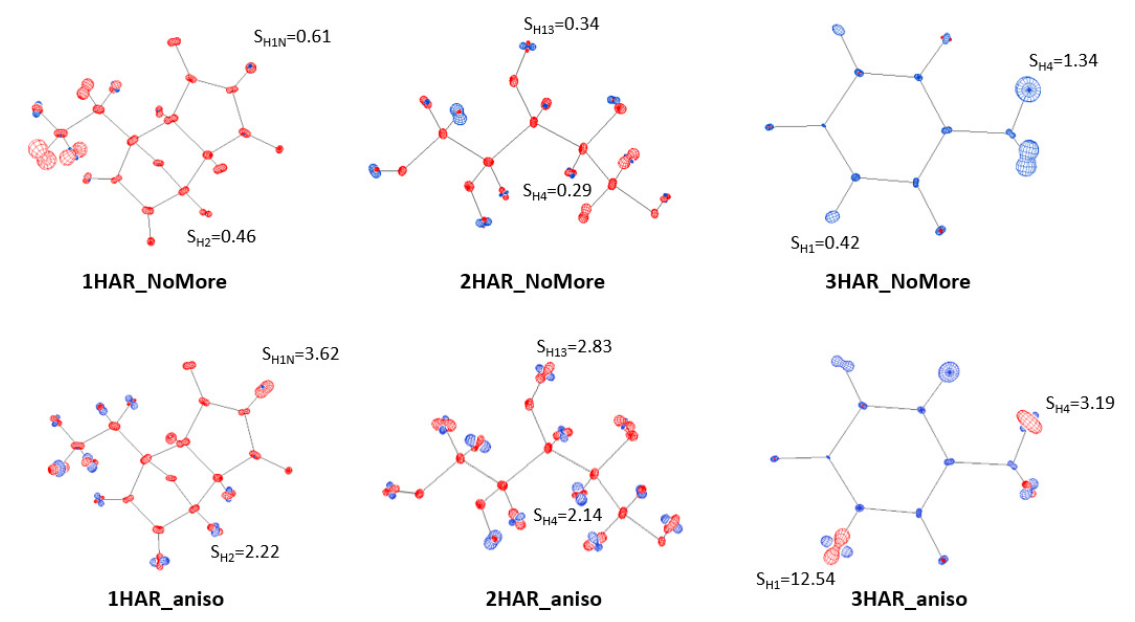
Figure 8. Differences between the ADPs of the neutron data and the analysed models for HAR_NoMoRe and HAR_aniso refinements of 1 , 2 , and 3 . A two-step overlay algorithm and 2.0 scale were applied using PEANUT software. Selected similarity index values (S HX , where x is an atom number) were added to the plots. PEANUT plots for MM, HAR_aniso, HAR_NoMoRe, HAR_SHADE, and TAAM_SHADE are available in the Supplementary Materials (Figures S27–S29).